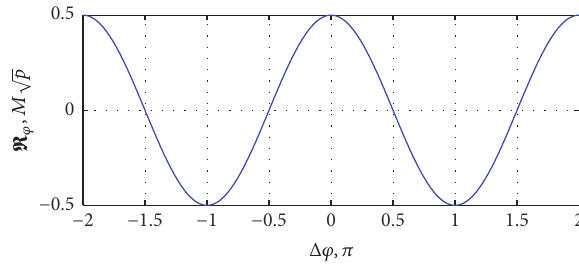
Figure 3: Relation between R 𝜑 and Δ𝜑